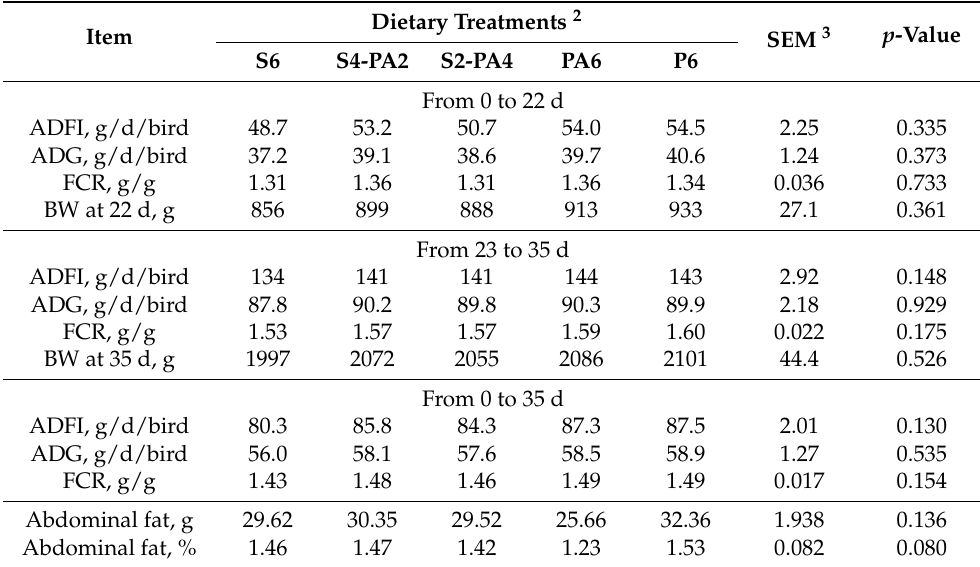
Table 4. Growth performance and abdominal fat pad deposition of broiler chickens according to different fat sources in diet 1